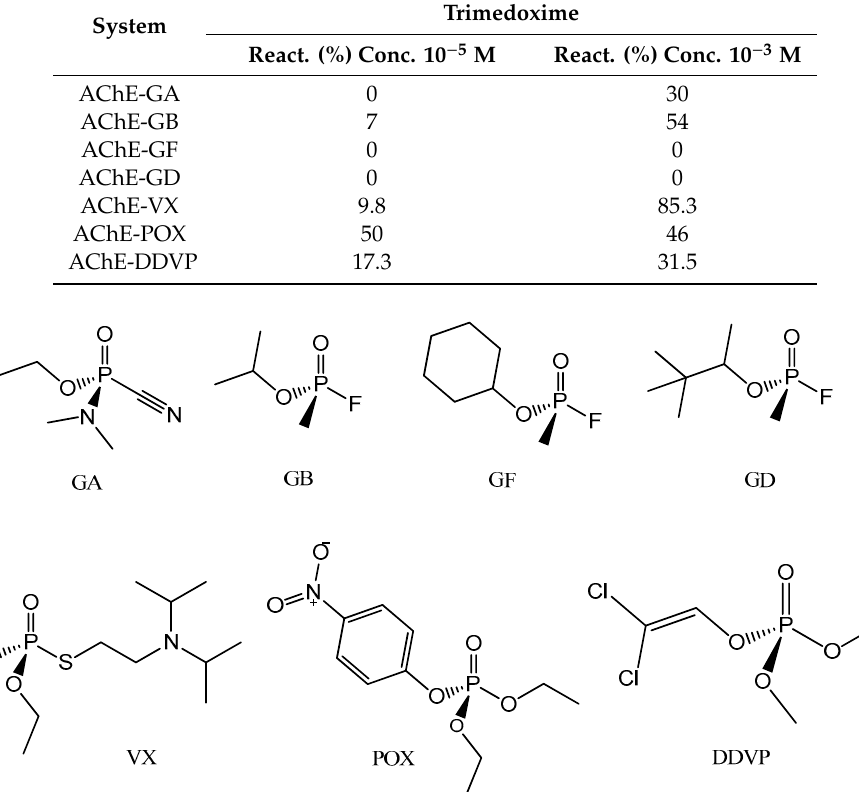
Table 1. Reactivation activity of trimedoxime (data obtained in triplicate experimental assays).